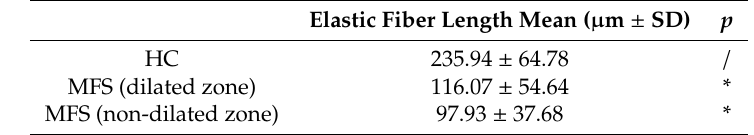
Figure 1. Collagen deposition, disease-related gene expression, and TGF- β -dependent pathways activation are higher in thoracic aortas of Marfan syndrome (MFS) patients than healthy controls. ( a ) Expression of MFS-related genes in total RNA extracts of thoracic aortas from healthy controls (HC) (green bars), MFS dilated (red bars), and MFS non-dilated zones (blue bars). qRT-PCR analyses have been performed in triplicate and data are shown as fold change ± SD, n = 5. Student’s t -test: * p < 0.05, ** p < 0.01. ( b ) Representative images of Verhoe ff –Van Gieson staining on HC (left panel) and MFS patient aortas (dilated zone, central panel; non-dilated zone, right panel). Magnification = 20 × . Scale bar = 200 µ m. ( c ) Collagen quantification data are shown as mean ± SD, n = 5. Student’s t -test: * p < 0.05. ( d ) Western Blot of active phosphorylated form and total SMAD2 / 3 and ERK1 / 2 in total protein extracts of thoracic aortas from HC (green bars), MFS dilated (red bars), and MFS non-dilated zones (blue bars), and relative quantification. Data are shown as mean ± SD, n = 5. Student’s t -test: * p < 0.05. ( e , f ) Quantification of phospho-SMAD2 / 3 ( e ) and phospho-ERK1 / 2 ( f ) Western blot on thoracic aortic tissues. Data are shown as mean ± SD, n = 5. Student’s t -test: * p < 0.05. Table 1. Elastic fiber length measurement in thoracic aortas of healthy controls (HC) and MFS